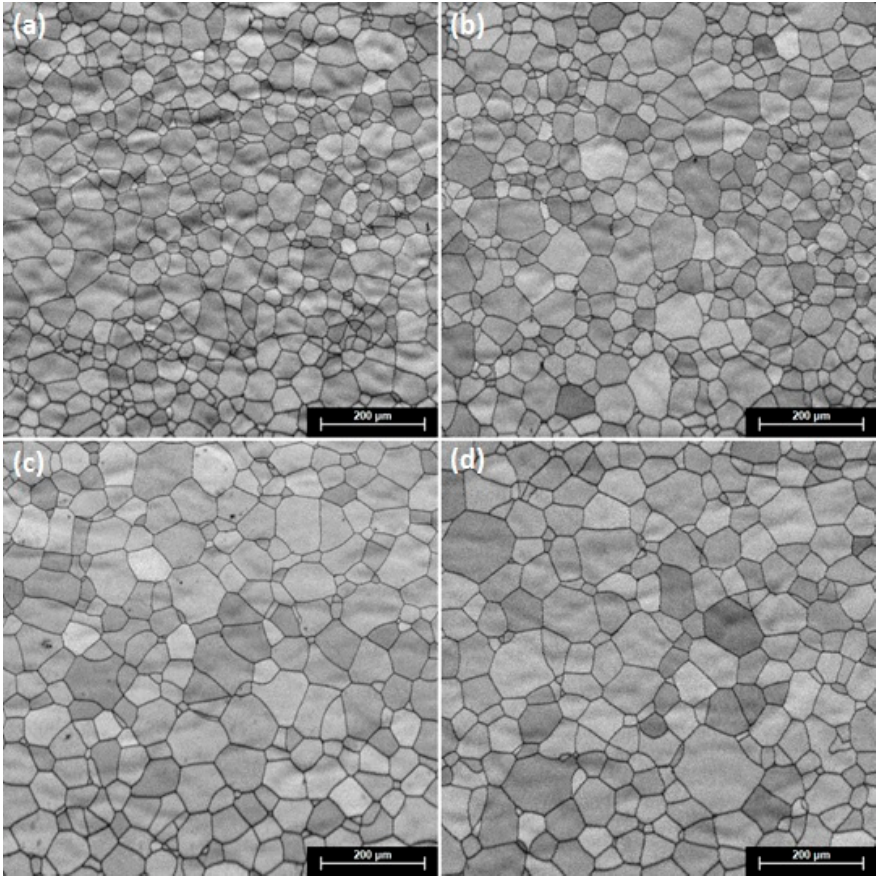
Figure 8. The SEM images of the (CR + solution treatment (ST) processed samples corresponding to the 2nd step of the 1st direction of the TMP Program with the same ε tot = 60% for the applied CR but with various STs: ( a ) CR + ST1 (1223 K/5 min./w.q.); ( b ) CR + ST2 (1223 K/10 min./w.q.); ( c ) CR + ST3